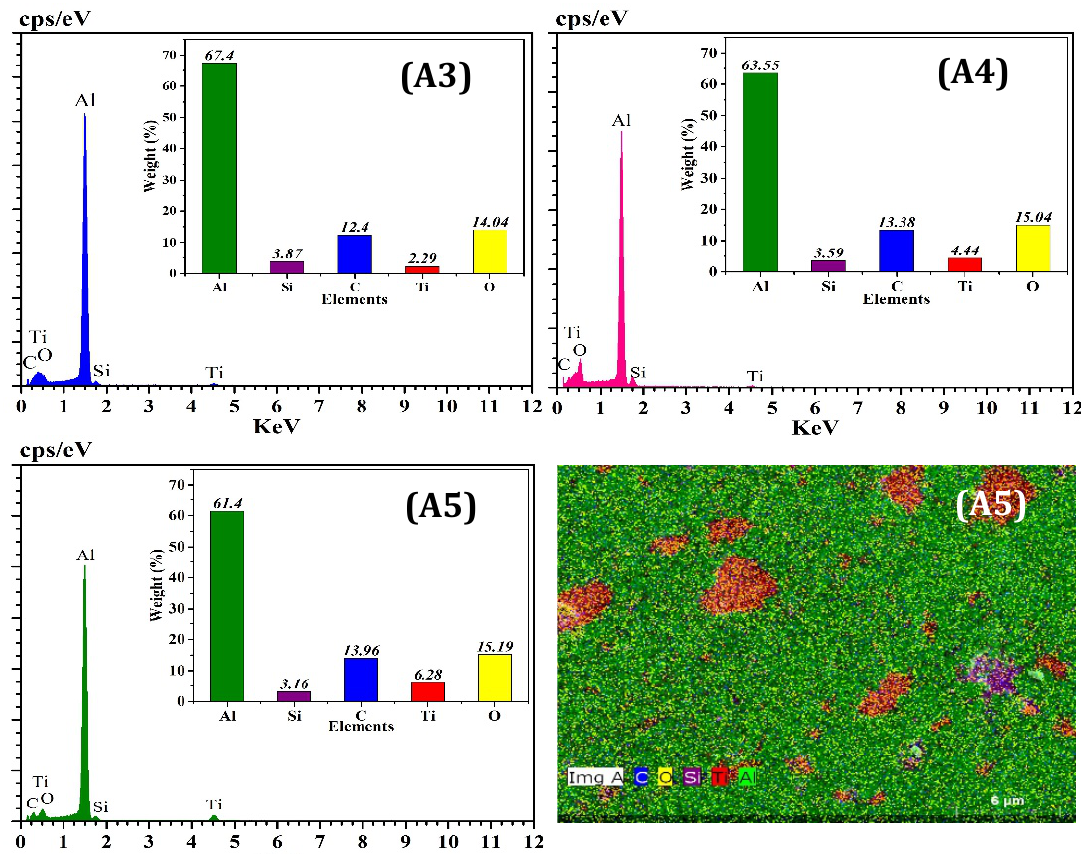
Figure 4. SEM micrographs of the ( A1 ) pure Al, ( A2 ) Al/5SiC, ( A3 ) Al/5SiC/3TiO 2 , and ( A5 ) Al/5SiC/9TiO 2 hybrid nanocomposites.